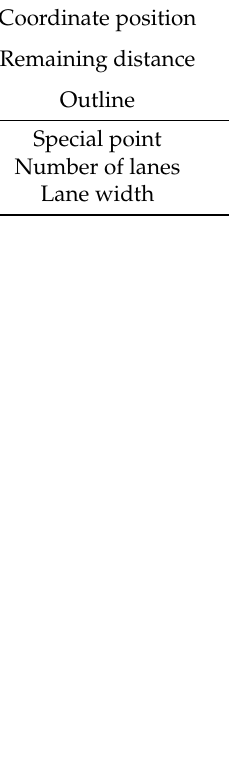
Table 2. Arrangement of experiment design and data